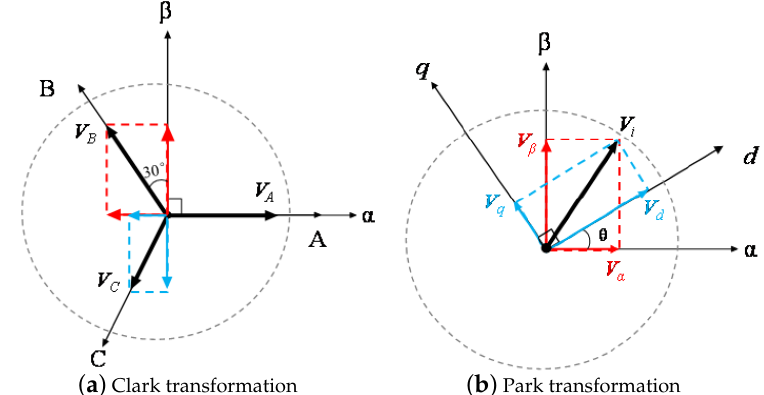
Figure 3. Coordinate transformation